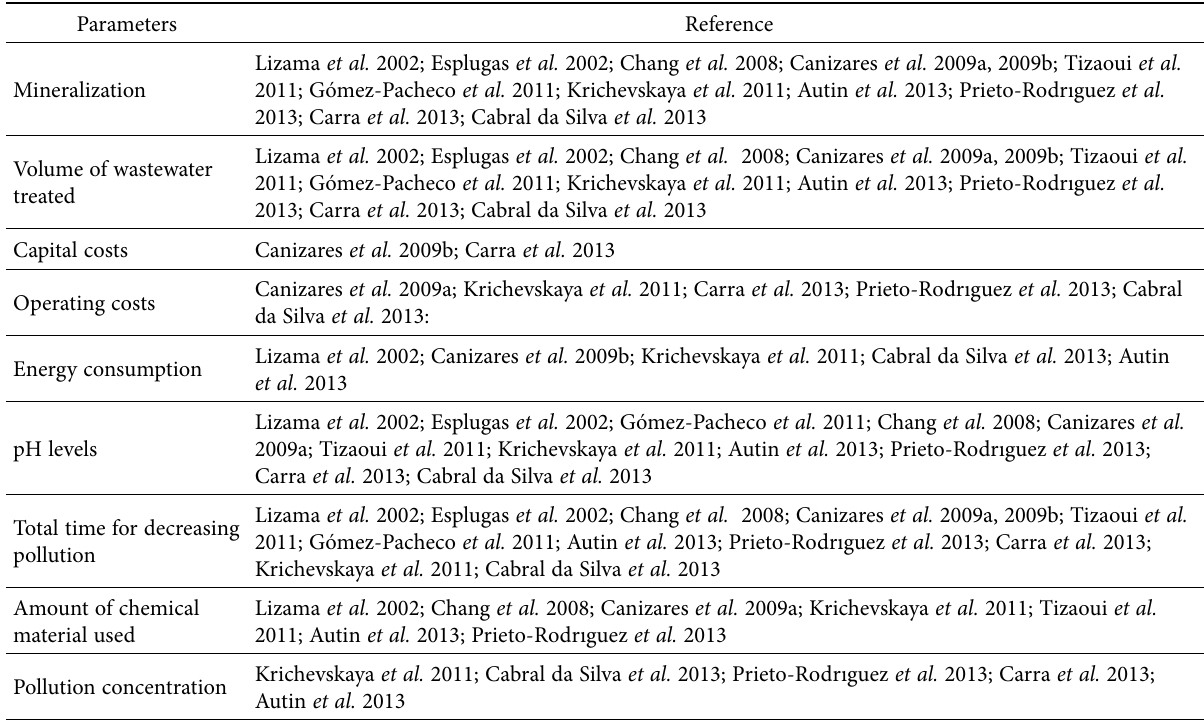
Table 1. The model of